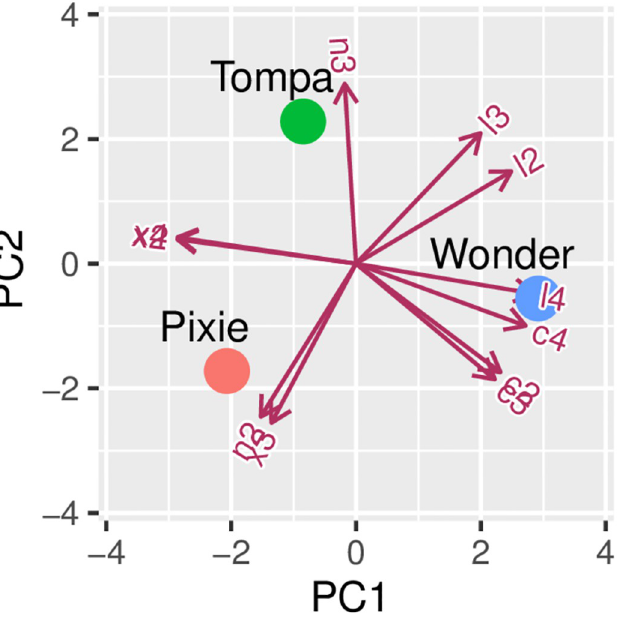
Fig 2. Biplot representation of the 11 variable means and of the three tree species constructed using the mean values reported in Table 3.